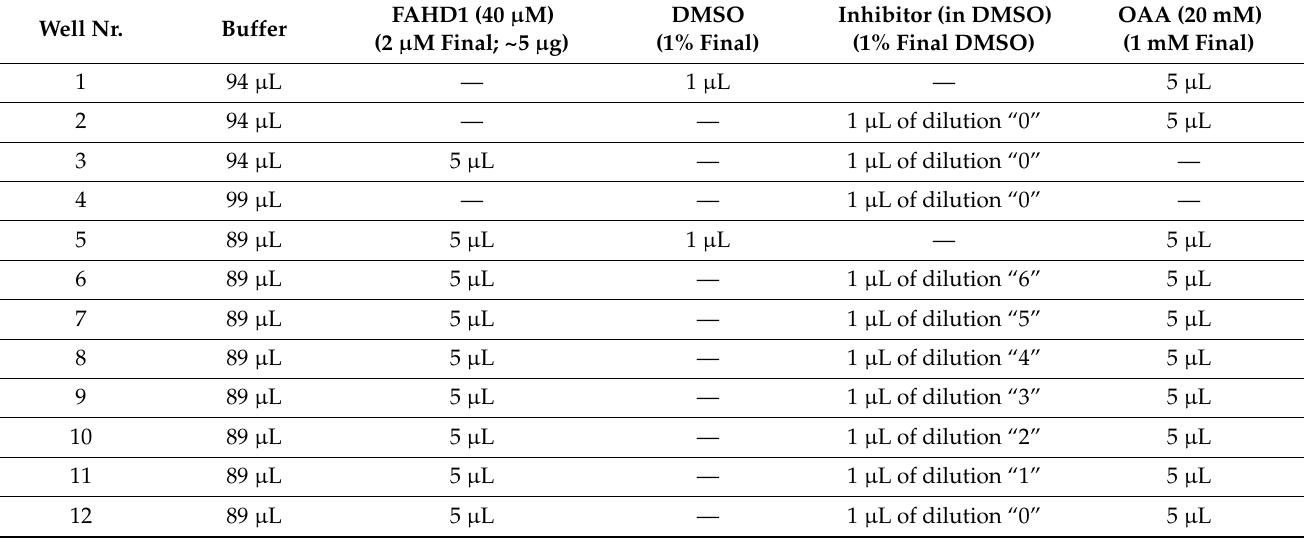
Table 10. Pipetting scheme for a direct ODx assay on the 96-well plate, to screen for IC 50 values of FAHD1 in vitro. Well